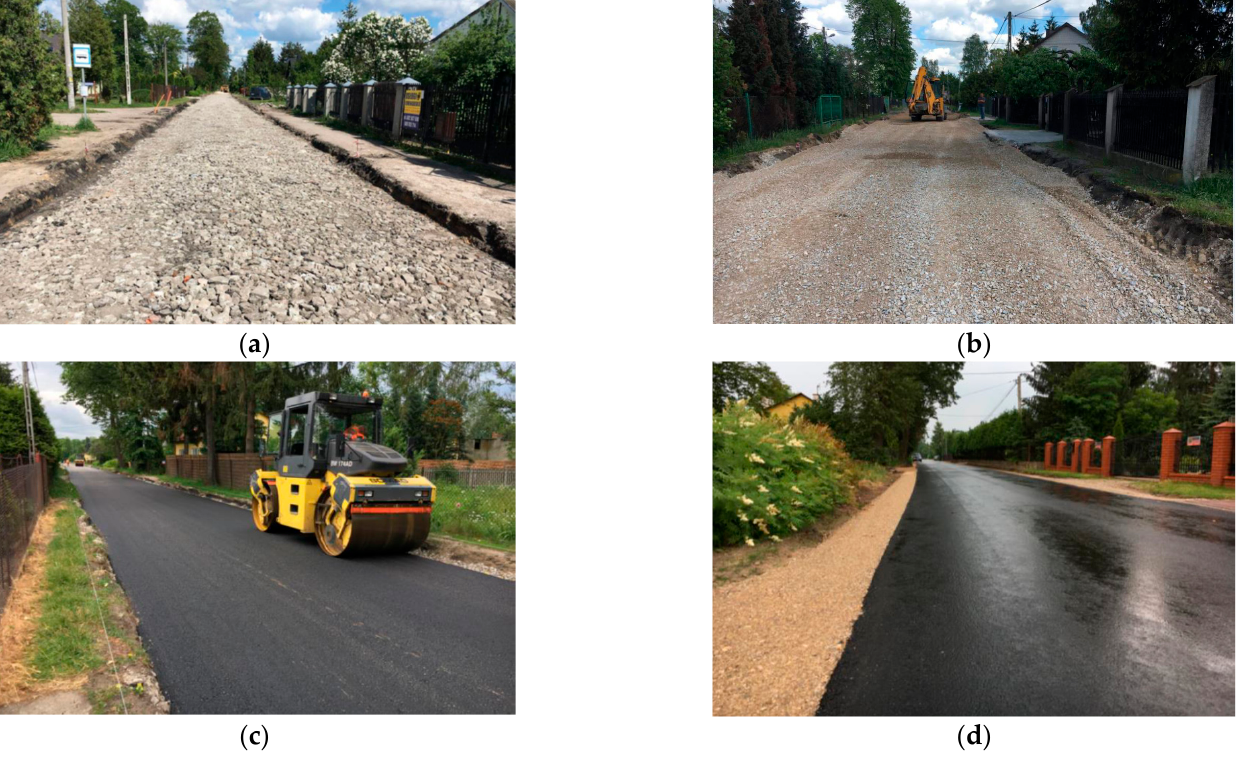
Figure 2. Construction process: ( a ) APSE sub-base using CDW, ( b ) Reference sub-base using virgin aggregates, ( c ) compaction of reference binder course layer with 30% RAP, ( d ) paved APSE trial section.